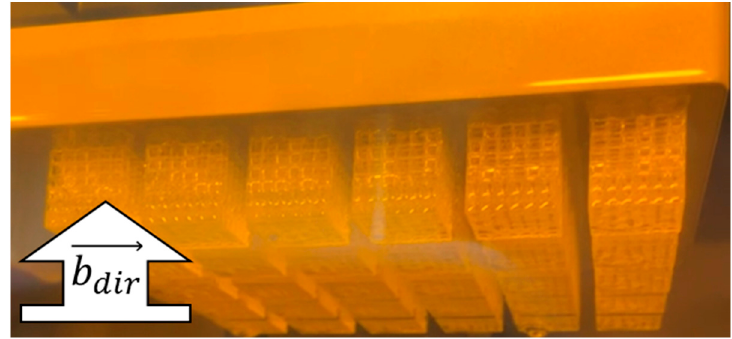
Figure 2. Fabricated lattices on build platform.